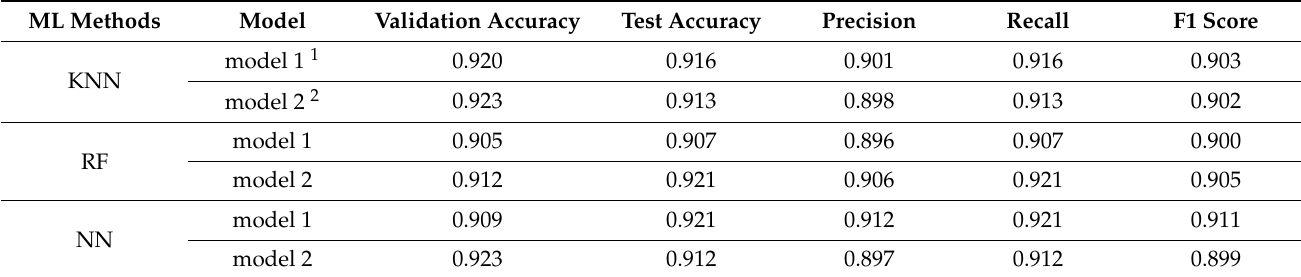
Table 2. Accuracy in each predictive model.